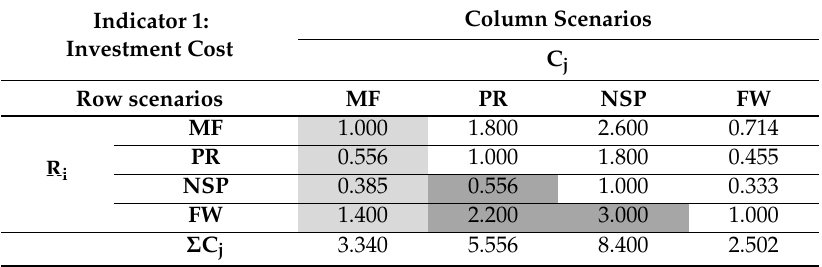
Table 8. Example matrix of pairwise comparisons of scenarios for indicator 1, Investment